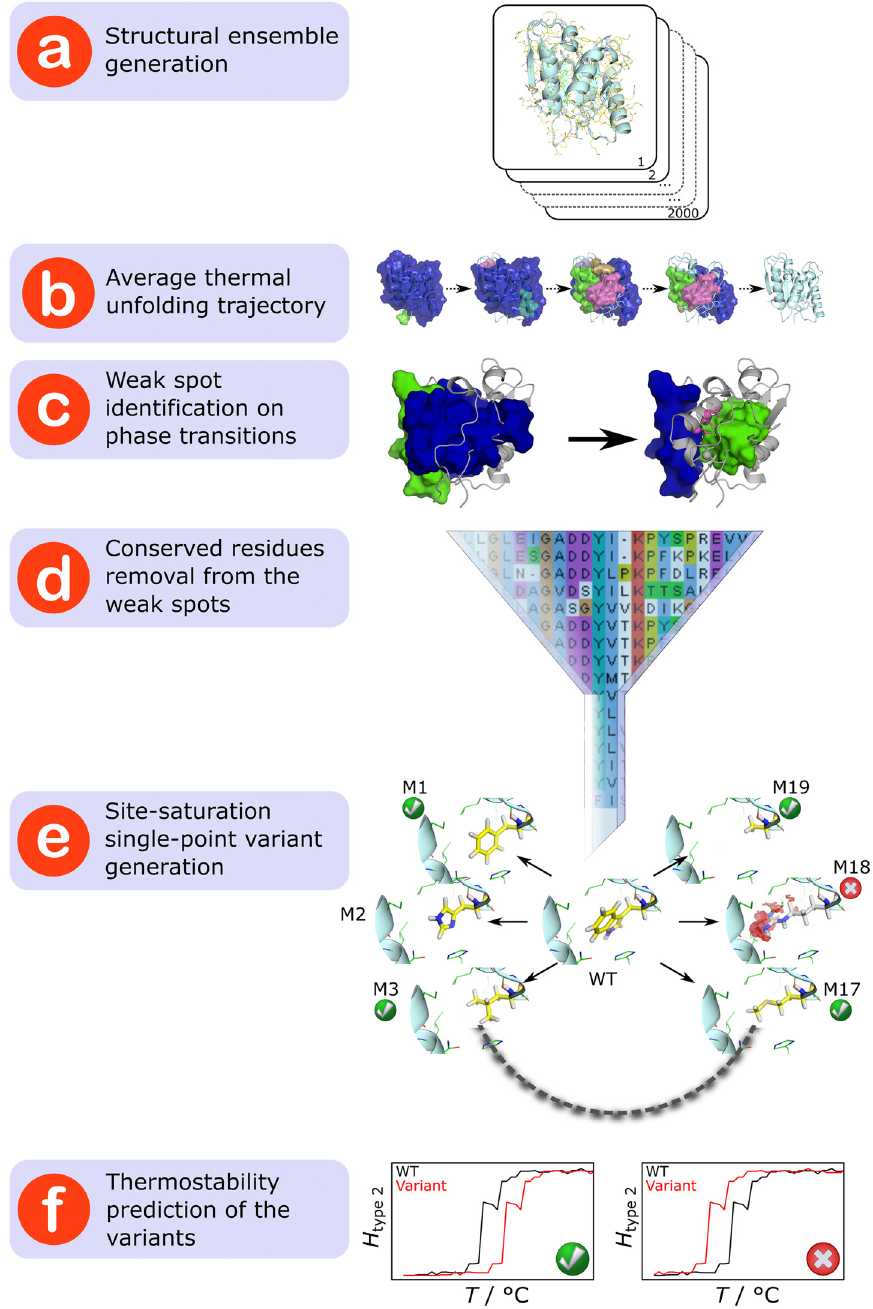
Fig 1. Strategy to rationally predict mutations that increase structural rigidity and thermostability. (a) A structural ensemble of the respective protein is generated by MD simulations. (b) The average thermal unfolding trajectory depicting a decomposition into rigid clusters (in the order of decreasing size colored in blue, green, magenta, cyan, orange, and violet) for each step of the unfolding simulation is created by subjecting the structural ensemble to CNA. (c) For every major transition during the thermal unfolding, weak spot residues (depicted as a sphere for the C α atom and sticks for the side-chain) are identified. (d) Weak spot residues that are highly conserved across the protein family ( (cid:1) 80% identity) are removed from the weak spot list. (e) For the rest, structures of site-saturation single-point variants (termed M1 – M19) are generated. Mutations that lead to energetically unfavorable structures (indicated by red discs around the mutated residue in the case of M18) are discarded. (f) For each variant, the phase transition temperature T p is computed using CNA; a higher T p value than that of the WT protein indicates a thermostabilizing mutation.